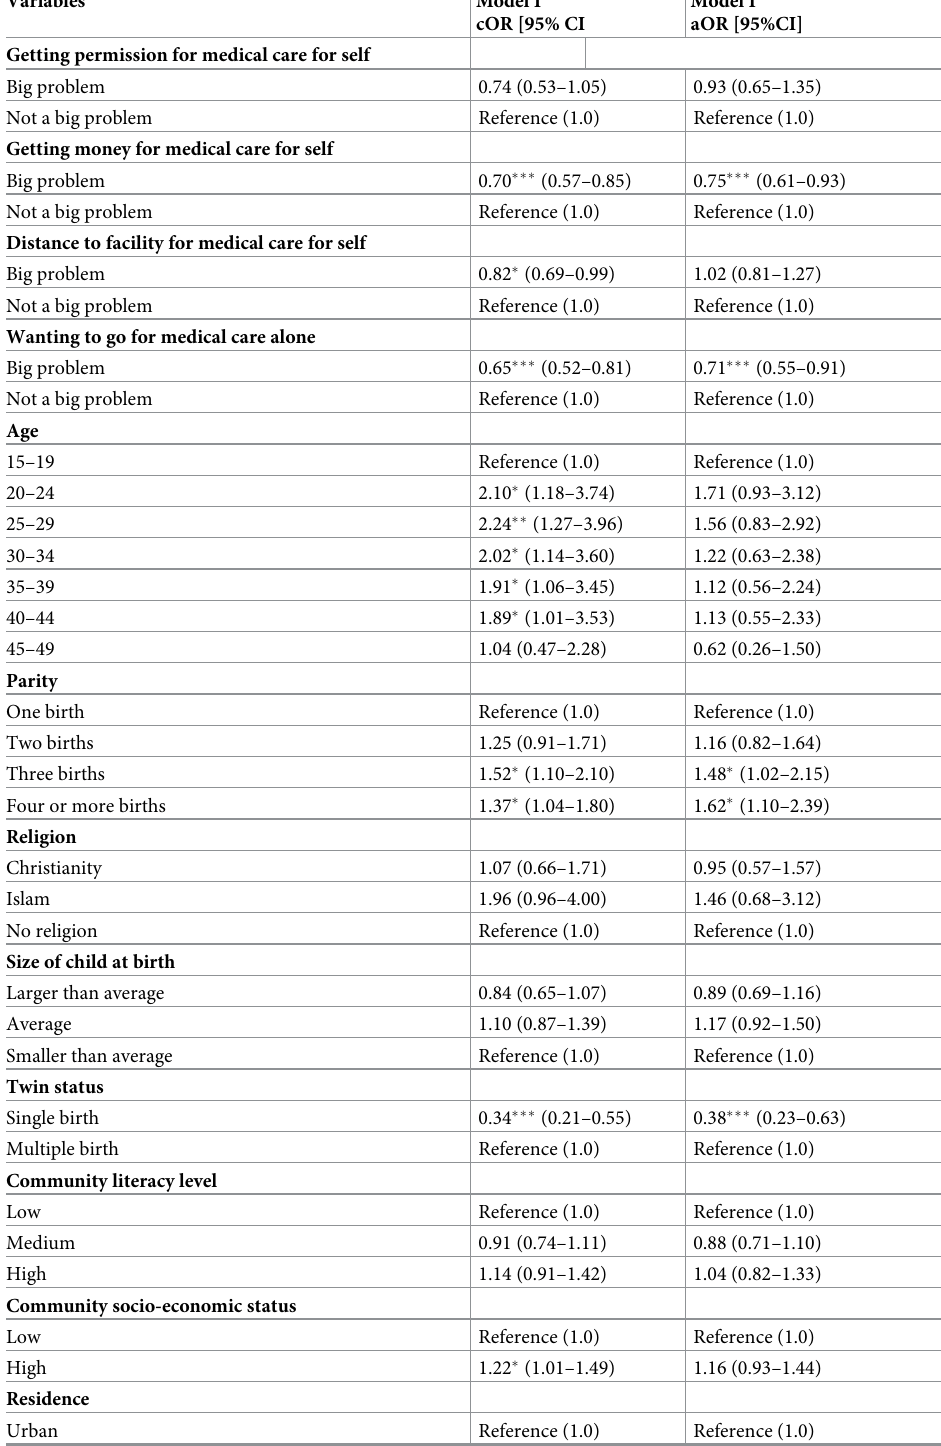
Table 2. Binary logistic regression results on the predictors of healthcare seeking for childhood illnesses in